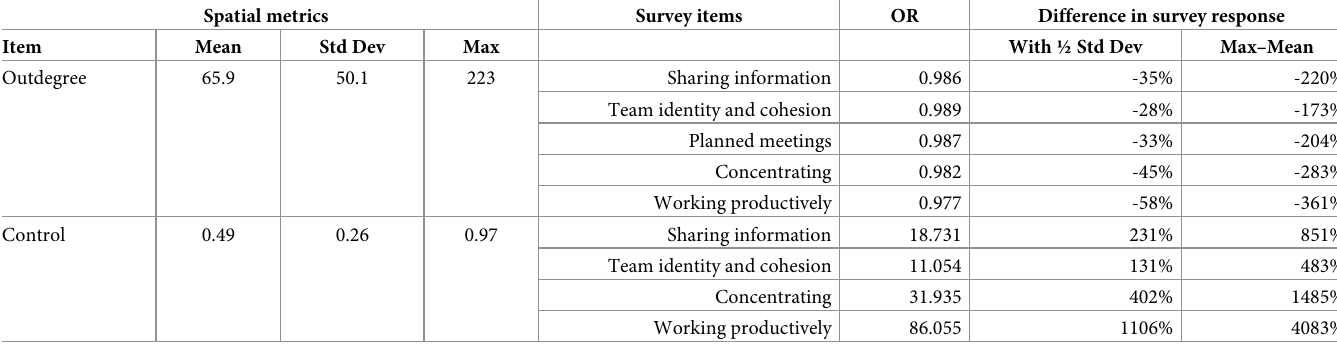
Table 3. Effects from the odds ratio for all significant continuous variables from the ordinal regression models. Spatial